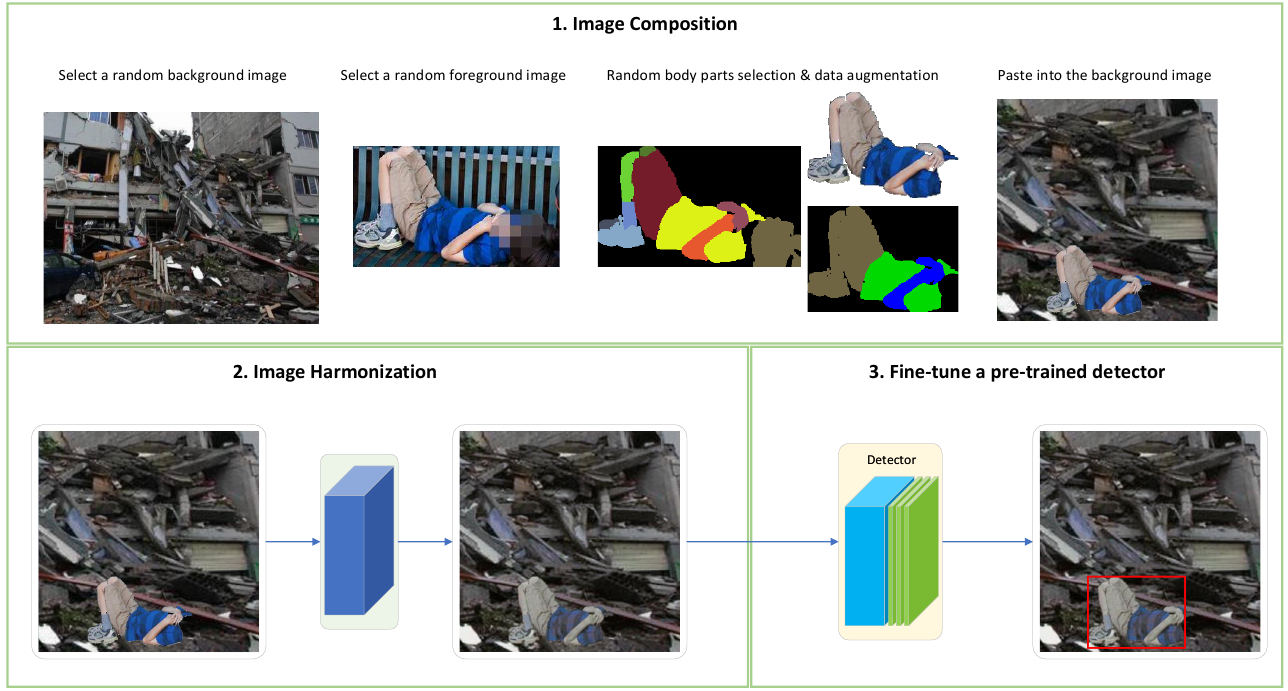
Figure 1. Our proposed framework consists of three steps: (1) image composition, (2) image harmo- nization, and (3) fine-tune a pre-trained